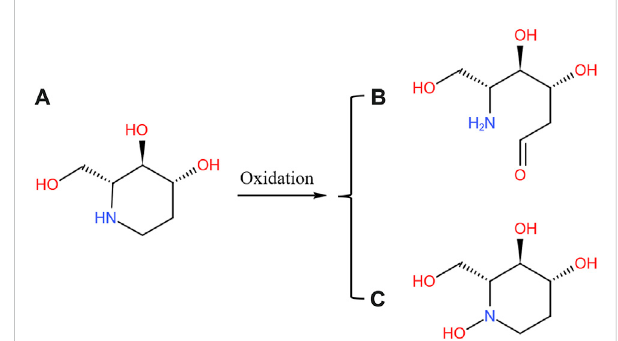
FIGURE 7 Possible oxidation pathway of FA (A) and its metabolites (B) and (C) . The metabolites of SZ-A were identi fi ed from the plasma samples of rats after oral administration of SZ-A (40 mg/kg) and the human liver microsomes (HLMs) and rat liver microsomes (RLMs) samples in the enzyme inhibition